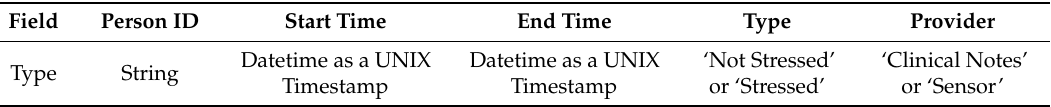
Table 3. Information schema for representing ground truth from clinical notes and analyzed sensor